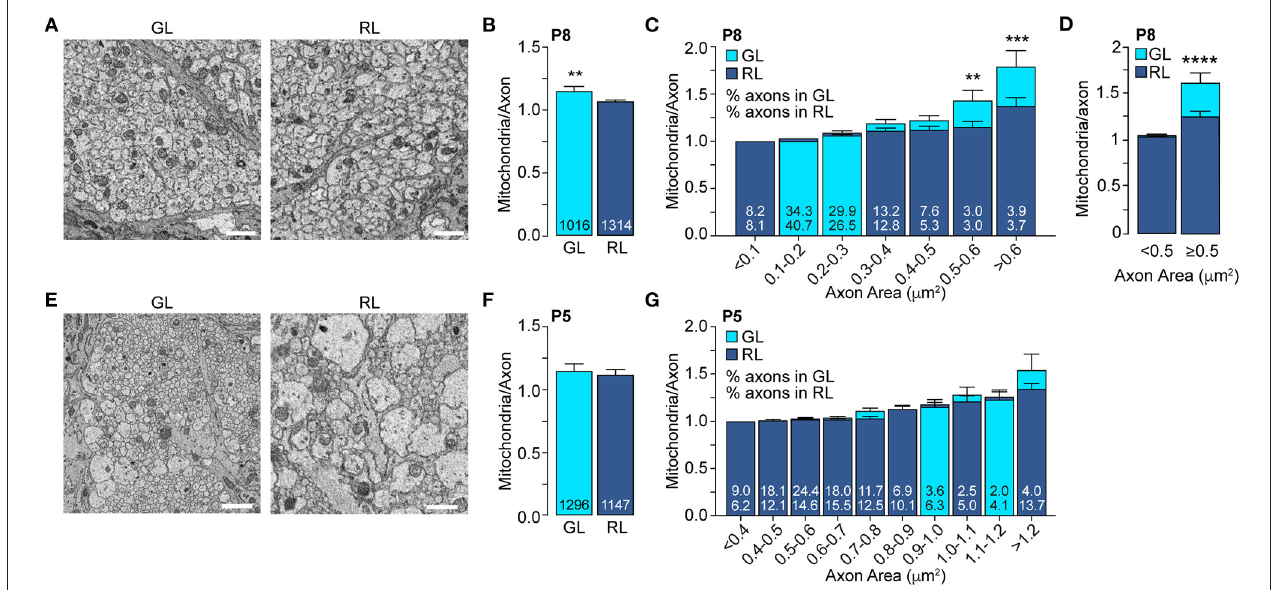
FIGURE 3 | The mitochondrial accumulation in large axons of the glial lamina is established between P5 and P8. (A) Representative electron micrographs of the axons in GL and RL of P8 mice. (B) Average number of mitochondria per axon in axons in GL and RL of P8 mice. The total number of axons is indicated in the bars. GL: n = 3 mice, 3 nerves. RL: n = 4 mice, 4 nerves. *** p = 0.004, Mann–Whitney test. (C) GL and RL average number of mitochondria per axons in P8 mice split by axonal area. The numbers within each superimposed bar represent the percentage of total axons falling within each area range for the GL (top) and RL (bottom). ** p = 0.006, *** p = 0.0002, Kruskal–Wallis test and Dunn’s multiple comparisons. (D) Average number of mitochondria per axon in the GL and RL for axons with areas smaller or bigger than 0.5 µ m 2 , **** p < 0.0001, Kruskal–Wallis test and Dunn’s multiple comparisons. (E) Representative electron micrographs of the GL and RL axons of P5 mice. (F) Average number of mitochondria per axon in GL and RL of P5 mice. The total number of axons are indicated in the bars. GL: n = 4 mice, 4 nerves. RL: n = 4 mice, 4 nerves. (G) GL and RL average number of mitochondria per axon in P5 mice split by axonal area. The numbers within each superimposed bar represent the percentage of total axons falling within each area range for the GL (top) and RL (bottom). Scale bar = 1 µ m. Error bars =